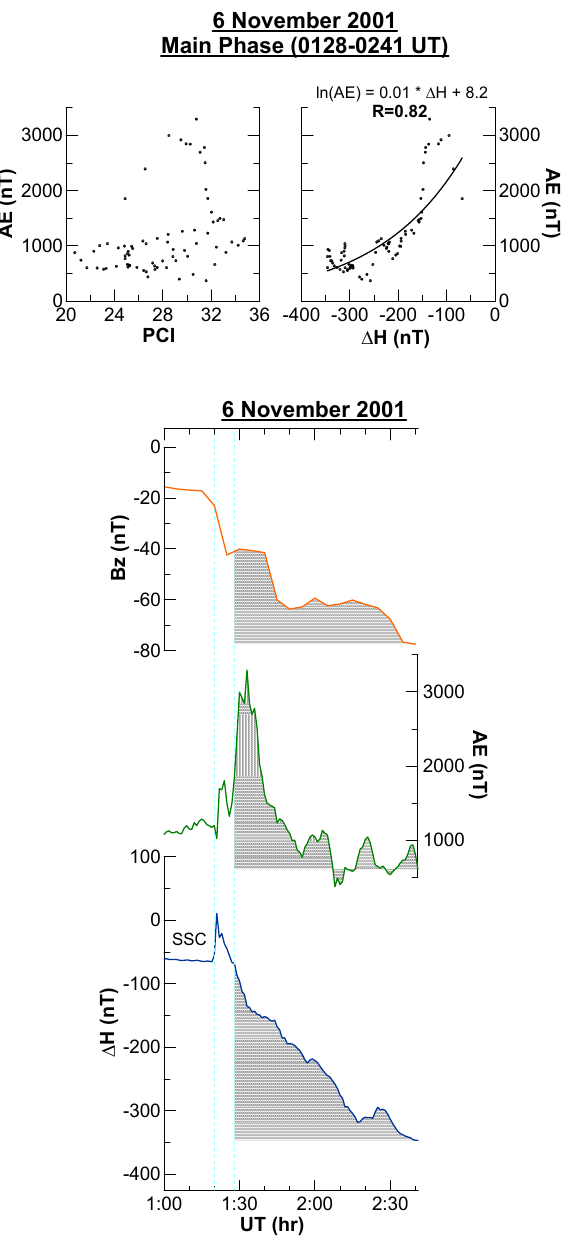
Fig. 10. Upper panel displays the correlations of polar cap magnetic activity ( PC ) index and low-latitude geomagnetic field 1H ABG with auroral electrojet ( AE ) index for 6 November 2001 for “ T 1” (01:28-02:41 UT) period. Bottom panel shows the variations of auroral electrojet index ( AE ) and 1H ABG with corresponding IMF B z .